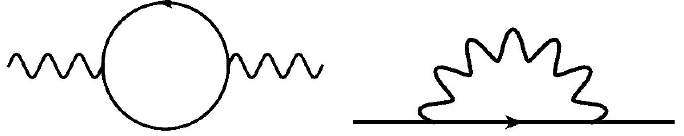
Figure 12 . Diagrams contributing to the (cid:13)ow of the anomalous dimension (cid:17) A (left) and (cid:17) (cid:30) (right). The explicit contributions in eq. (C.3) are gauge dependent, so we now add the ex- pressions for the anomalous